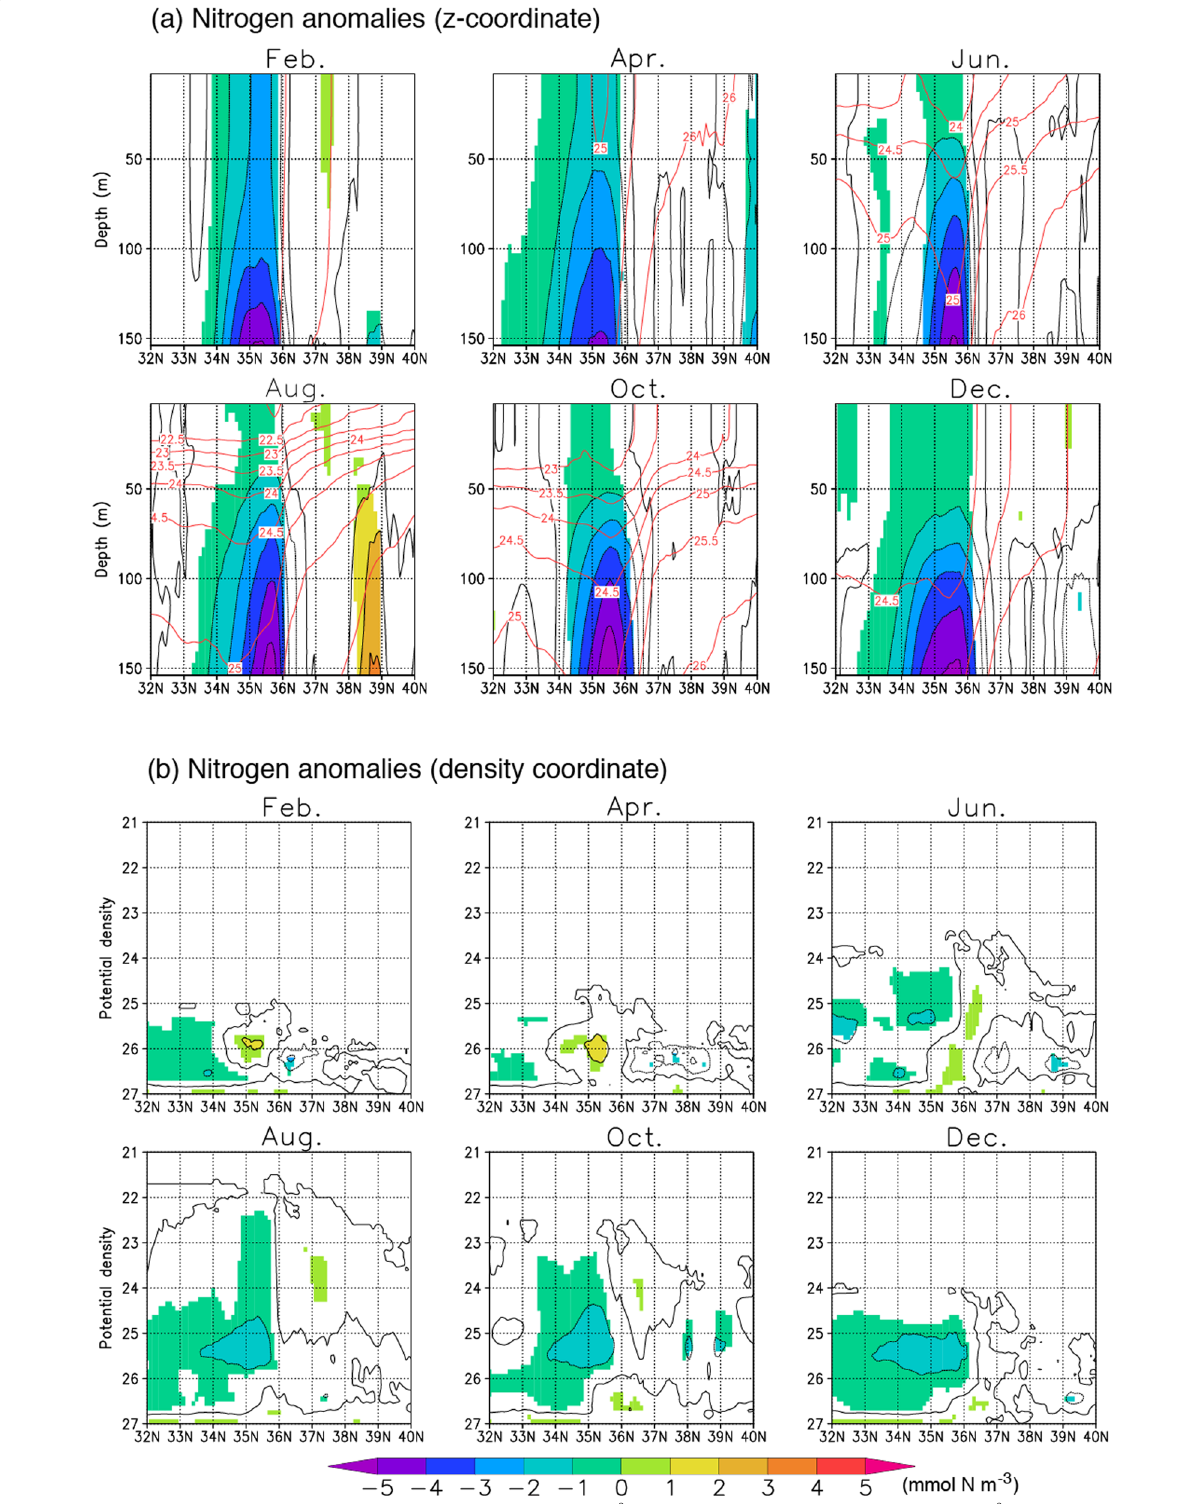
Fig. 7 As in Fig. 5, but for nitrogen concentration anomalies (in mmol N m − 3 ). The black contour intervals are 1 mmol N m −